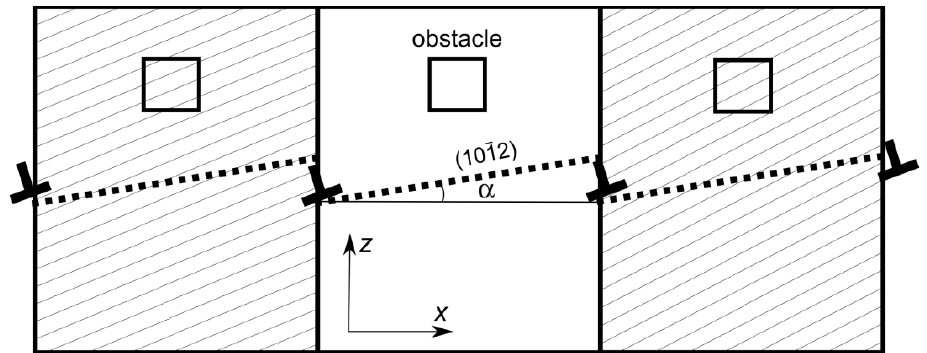
Figure 1. Scheme of the simulation block. The dashed line corresponds to the twin boundary. Shaded areas are periodic images of the central block. Twinning disconnections produce steps on the twin boundary due to periodic boundary conditions.